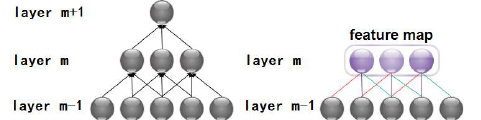
Figure 4. Structure of PV-DM training sentence vector.